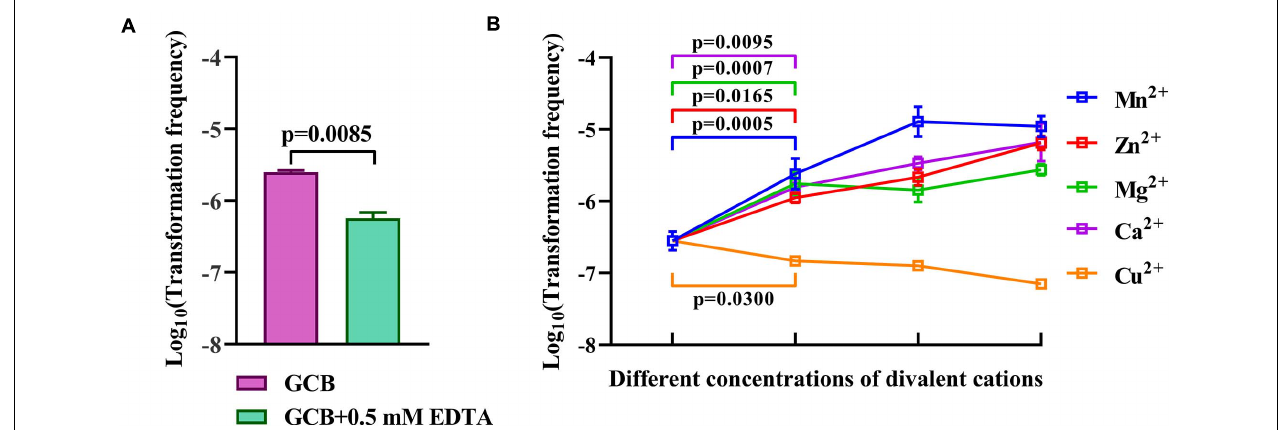
FIGURE 6 | Effect of EDTA and different divalent cations on the natural transformation of R. columbina . (A) Viable bacteria were counted after treatment with or without 0.5 mM EDTA for 1 h, and the effect of 0.5 mM EDTA on the natural transformation of R. columbina was determined. The P -value refers to the difference between the TF in GCB and in GCB containing 0.5 mM EDTA. (B) The natural TF of R. columbina in GCB supplemented with 0.5 mM EDTA and different supplemented concentrations of divalent cation. The concentration of Ca 2 + are 0.5, 1, and 5 mM, respectively. The concentration of Mg 2 + are 0.5, 1, and 5 mM, respectively. The concentration of Zn 2 + are 0.1, 0.2, and 0.5 mM, respectively. The concentration of Mn 2 + are 0.2, 0.5, and 1 mM, respectively. The concentration of Cu 2 + are 0.1, 0.2, and 0.5 mM, respectively. The P -value refers to the difference between the TF in GCB containing 0.5 mM EDTA and GCB containing 0.5 mM EDTA supplemented by Ca 2 + , Mg 2 + , Mg 2 + , or Cu 2 + , respectively. All the results are representative of three independent experiments. Error bars denote standard